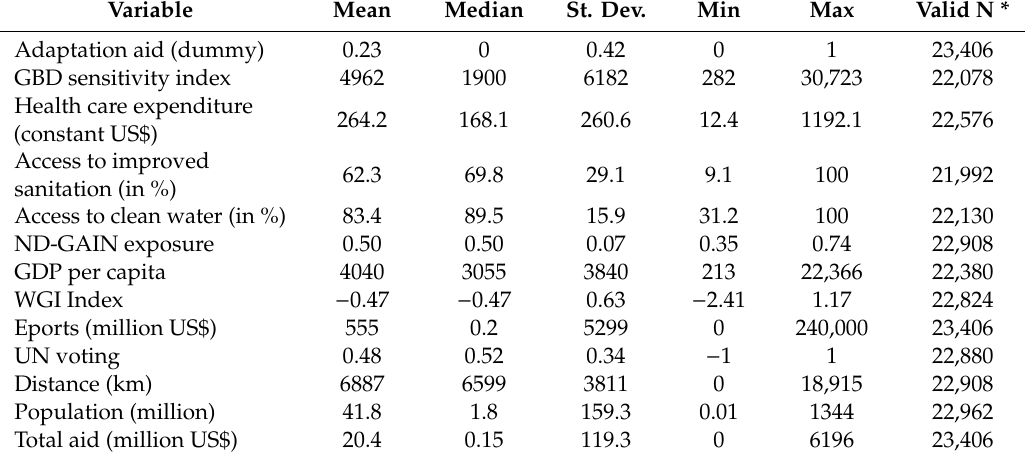
Table 1. Summary statistics for all numerical variables used in the statistical models (before transformation, if